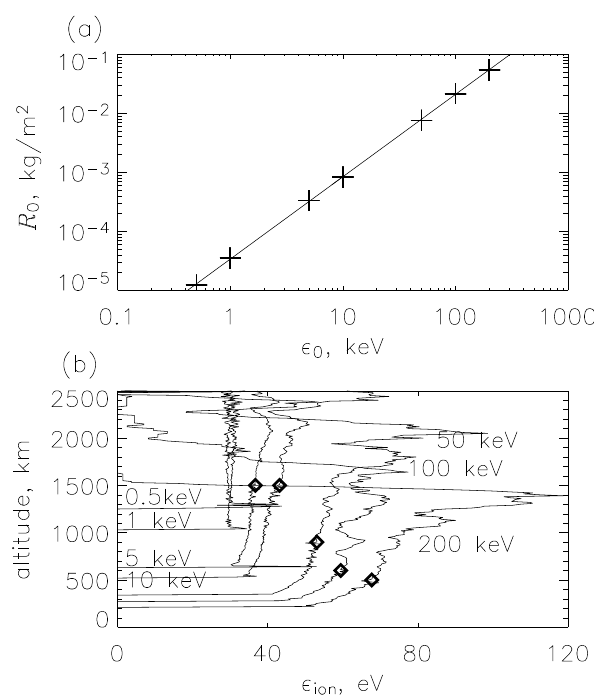
Figure 3: 2007.12.18: Y. Hiraki and C. Tao Fig. 3. (a) The column mass density R 0 of air above the stopping height of electrons as a function of their initial energy ε 0 . The solid line shows a fitted function of 3 . 39 × 10 − 5 ε 1 . 39 . (b) Altitude dis- 0 tribution of the average ion-yield energy ε ion , above the altitude denoted by diamonds, which are smoothed between 10 points for the sake of the exclusion of a large noise.